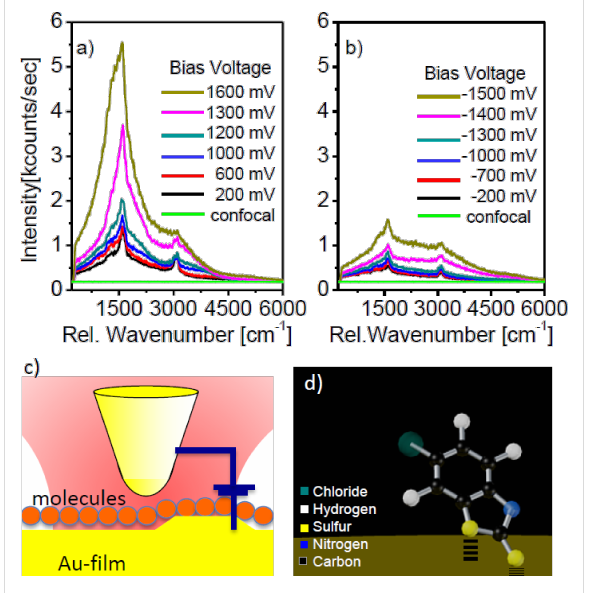
Figure 1: Sequences of tip-enhanced spectra (a,b) (Raman lines on luminescence background) recorded from the tunneling junction under constant laser illumination as a function of the positive and negative bias voltages, respectively. As a comparison, the confocal spectrum collected without the presence of the tip is shown as well (green lines). Typical tunneling junction (c) with a sharp gold tip statically positioned one nanometer above a gold substrate covered with a monolayer of chemisorbed Cl-MBT-molecules. Sketch of a Cl-MBT molecule (d) bound to the Au surface, after